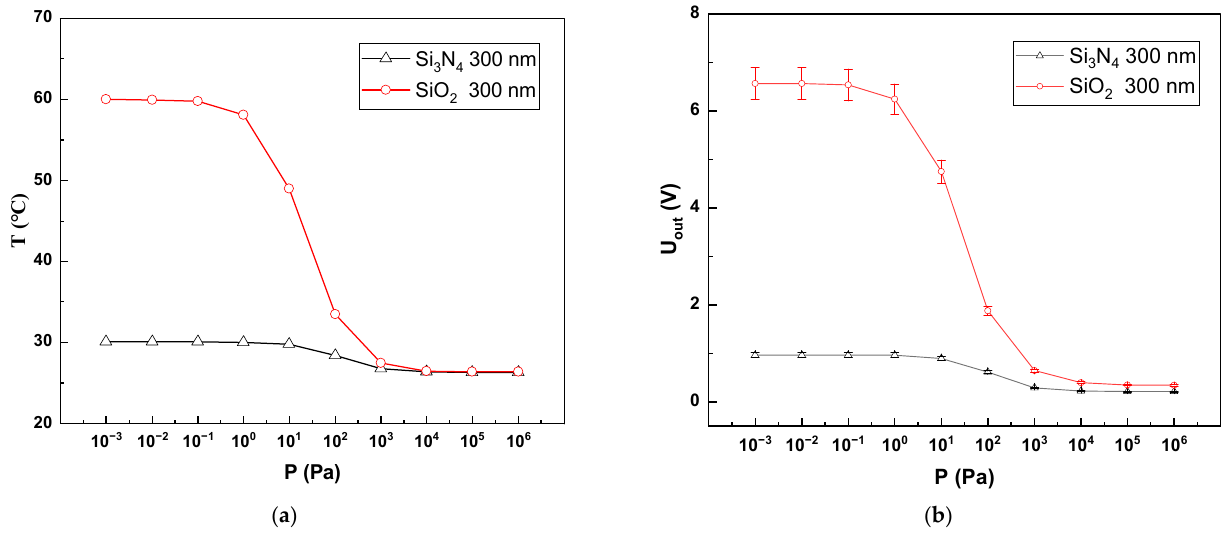
Figure 6. Ranges of Pirani gauges at different support materials. ( a ) Trend of thermal layer temper- ature with pressure for different support layer materials; ( b ) Trend of Pirani gauge output voltage with pressure for different support layer materials.